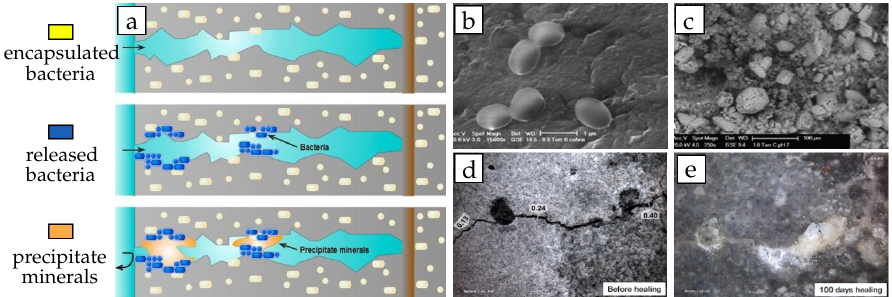
Figure 4. Self-healing mechanism using bacterial spores. ( a ) Schematic diagram of bacterial repair of concrete cracks. Bacteria on the surface of the crack are activated by water and precipitate minerals such as calcite to seal the crack and protect the reinforcement from external chemical attack. Reproduced